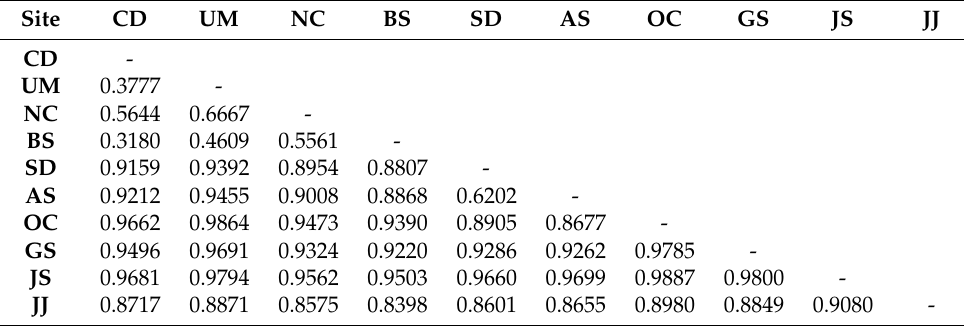
Table 6. Pairwise differences in the genes among the regional population by the distance method using the mitochondrial COII